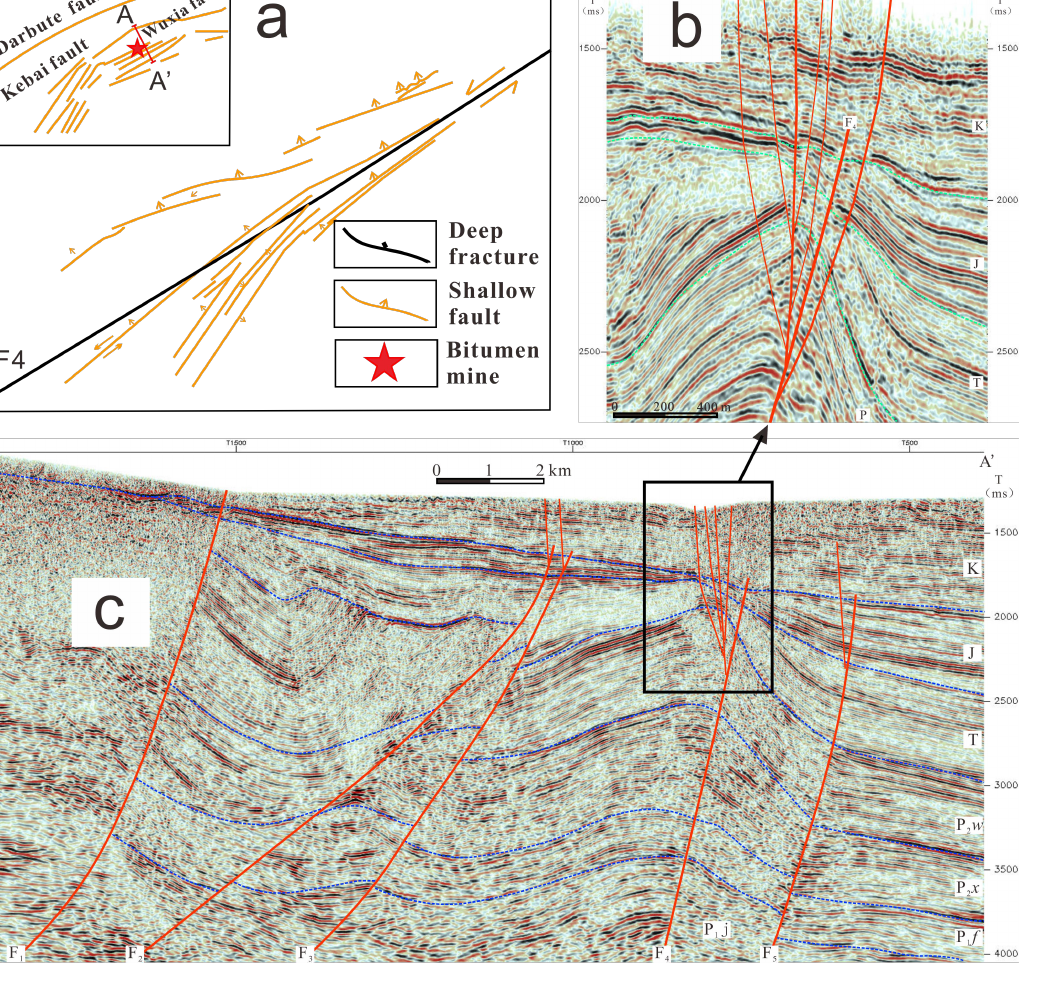
Figure 3. Structural characteristics of Wuerhe nose uplift, showing the two sets of deep and shallow faults are connected with each other on the profile, forming a “Y” type combination, which provides a channel for oil migration ( a – c